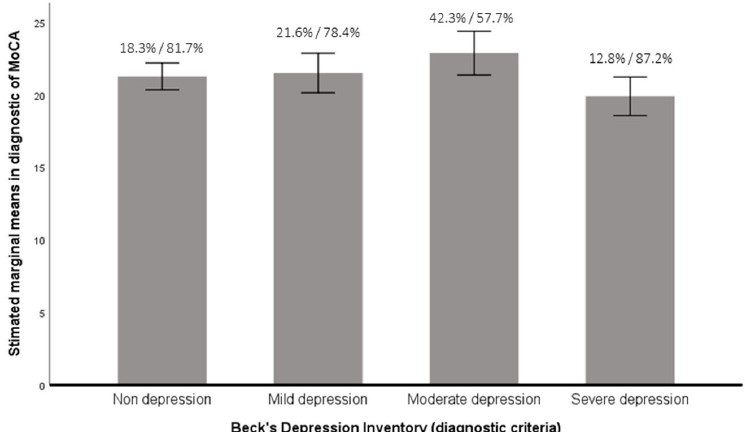
Figure 2. Mean differences in the level of depression experienced considering the score in cognitive impairment across MoCA (Montreal Cognitive Assessment, scores under 26 are considered as cognitive impairment). The percentages on each column indicate the distribution according to the diagnostic criteria in “normal cognitive performance” versus “cognitive impairment or early demen ‐ tia”.